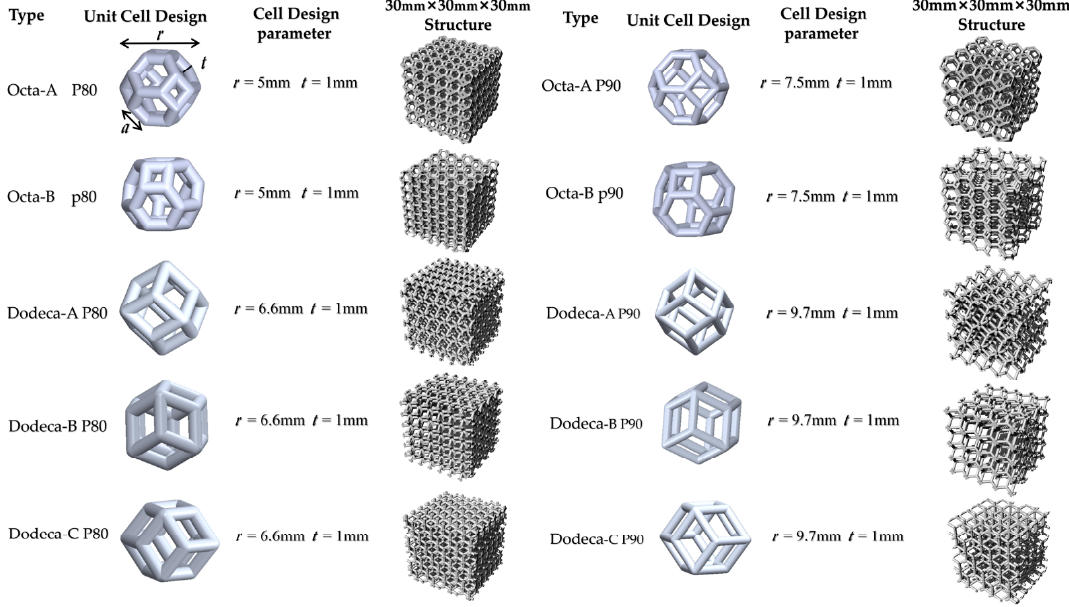
Figure 1. Unit-cell design, cell-design parameters and CAD models.